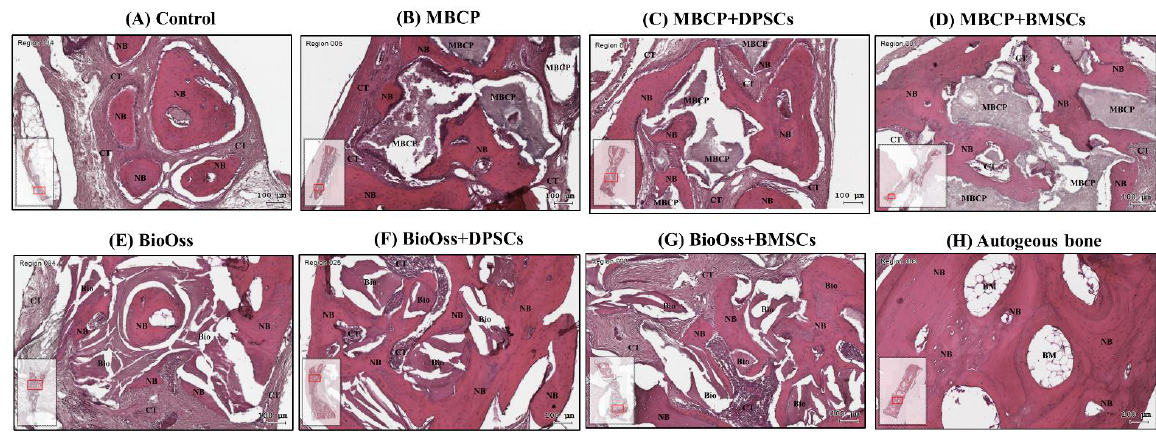
Figure 7. Histological analysis of calvarial bone defects after 4 weeks of healing in ( A ) the empty control, ( B ) MBCP, ( C ) MBCP+DPSCs, ( D ) MBCP+BMSCs, ( E ) Bio-Oss, ( F ) Bio-Oss+DPSCs, ( G ) Bio-Oss+BMSCs, and ( H ) autogenous bone groups. NB = new bone, CT = connective tissue, MBCP = MBCP, Bio = Bio-Oss, and AB = autogenous bone. Scale bar = 100 μm.